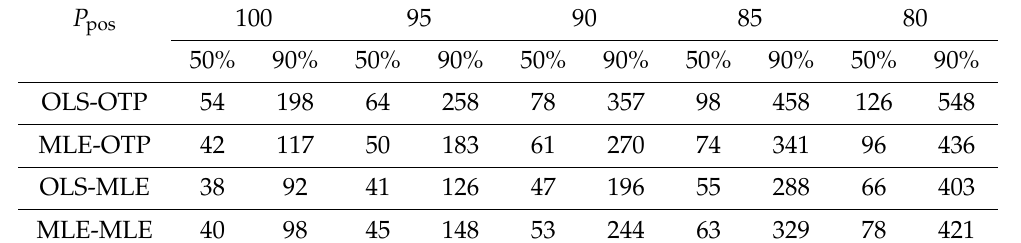
Table 6. Positioning error, in meters, 50th and 90th percentiles of Example 3 (28 GHz) with variable LOS detection probability in the positioning phase P pos . Base stations have directional antennas ( N = 8) and the average number of contacted BSs is N BS = 10.